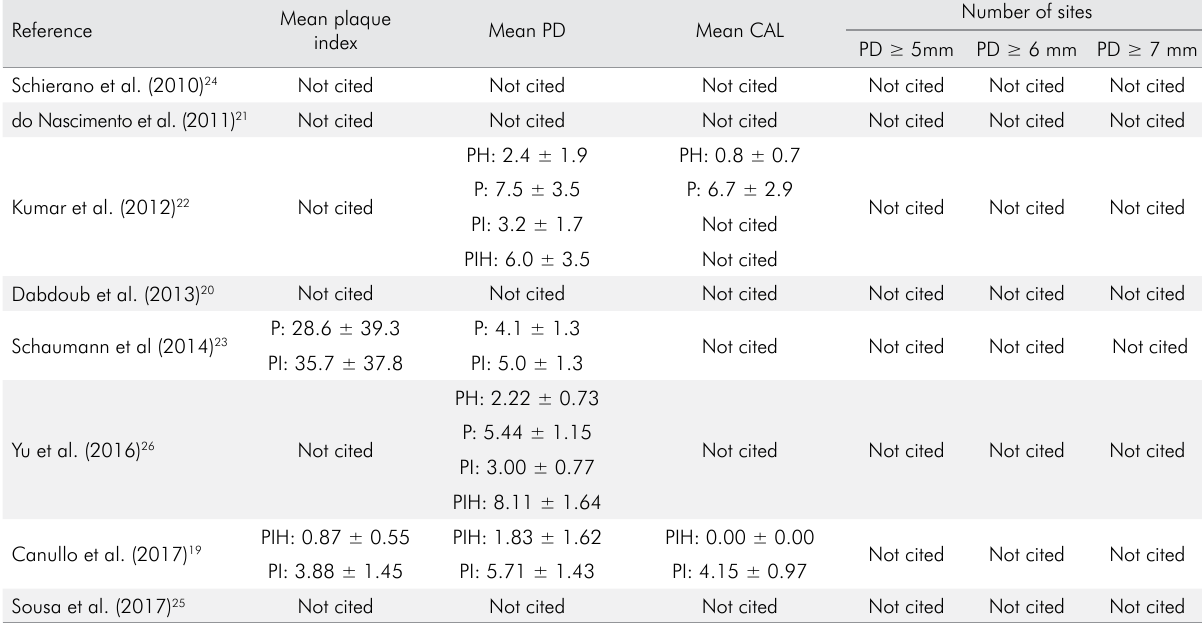
Table 4. Clinical characteristics of the study volunteers.